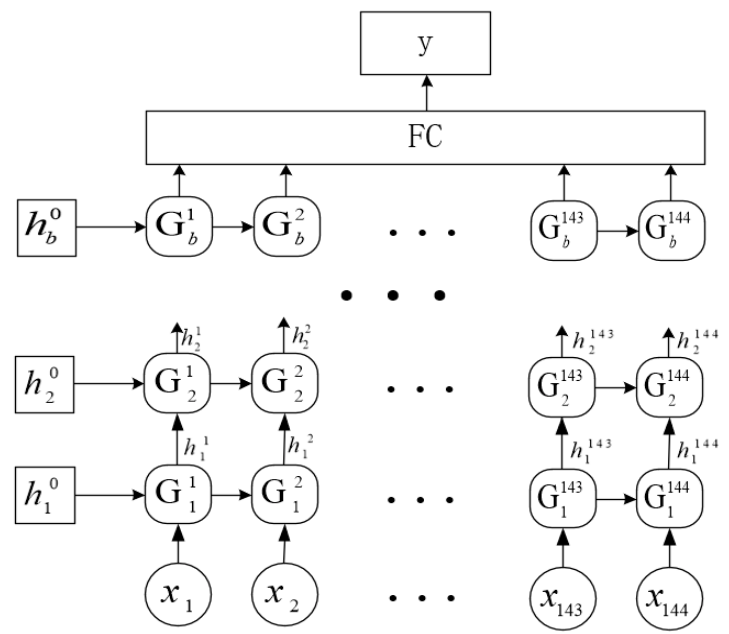
Figure 2. Schematic diagram of the proposed GRU neural networks.